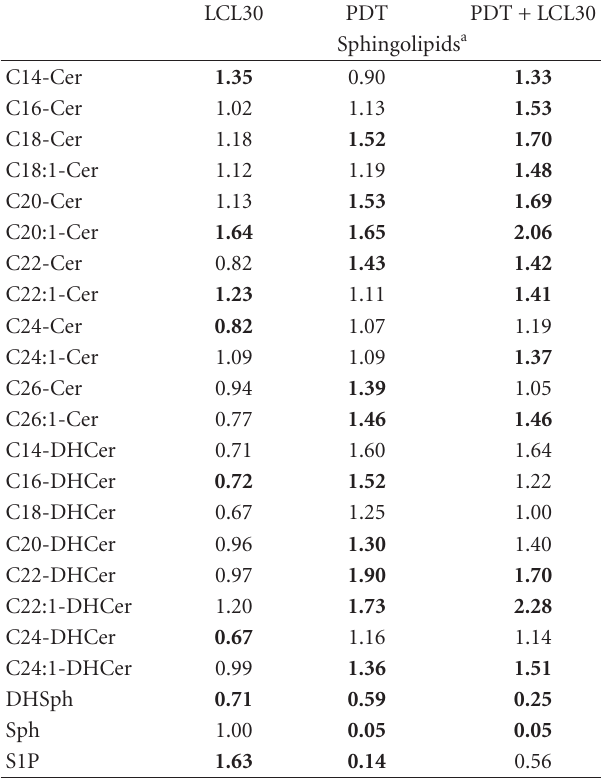
Table 1: The e ff ect of LCL30, PDT, and PDT + LCL30 on the SL profile in SCCVII